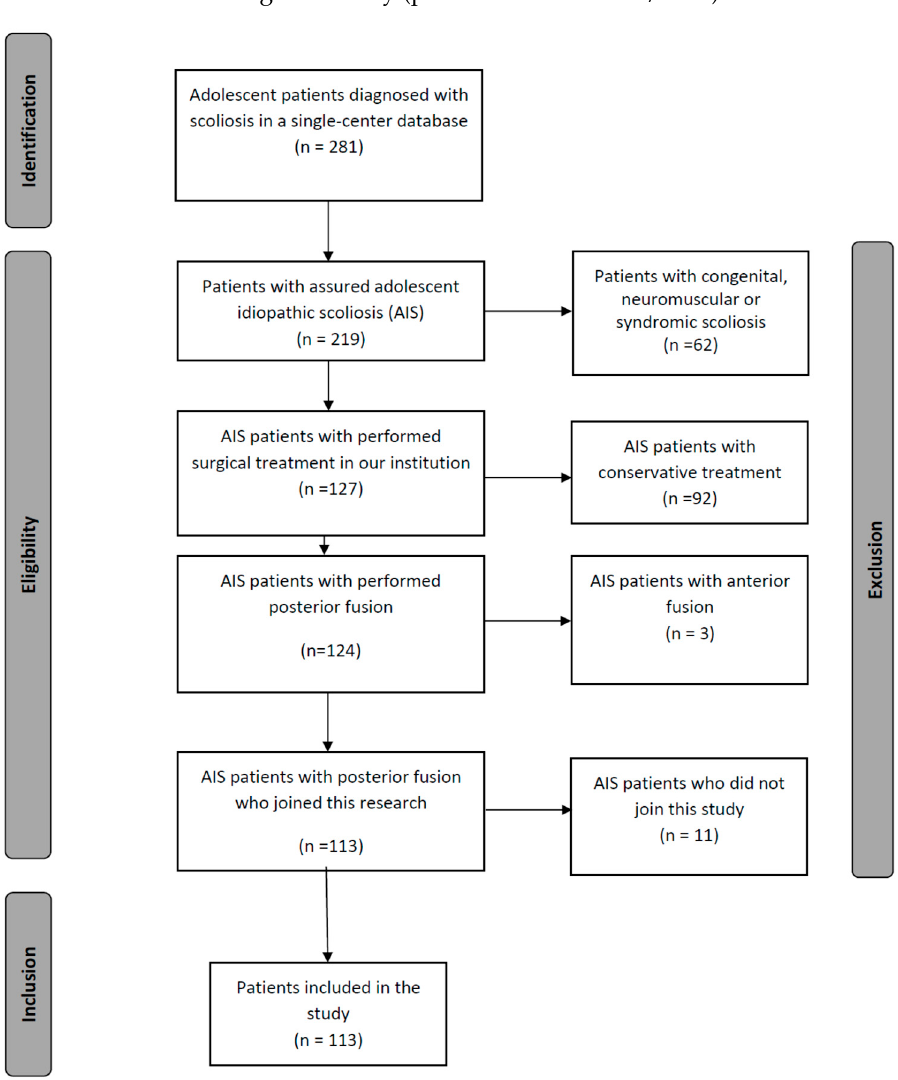
Figure 1. Flow diagram describing the inclusion process of the study population.